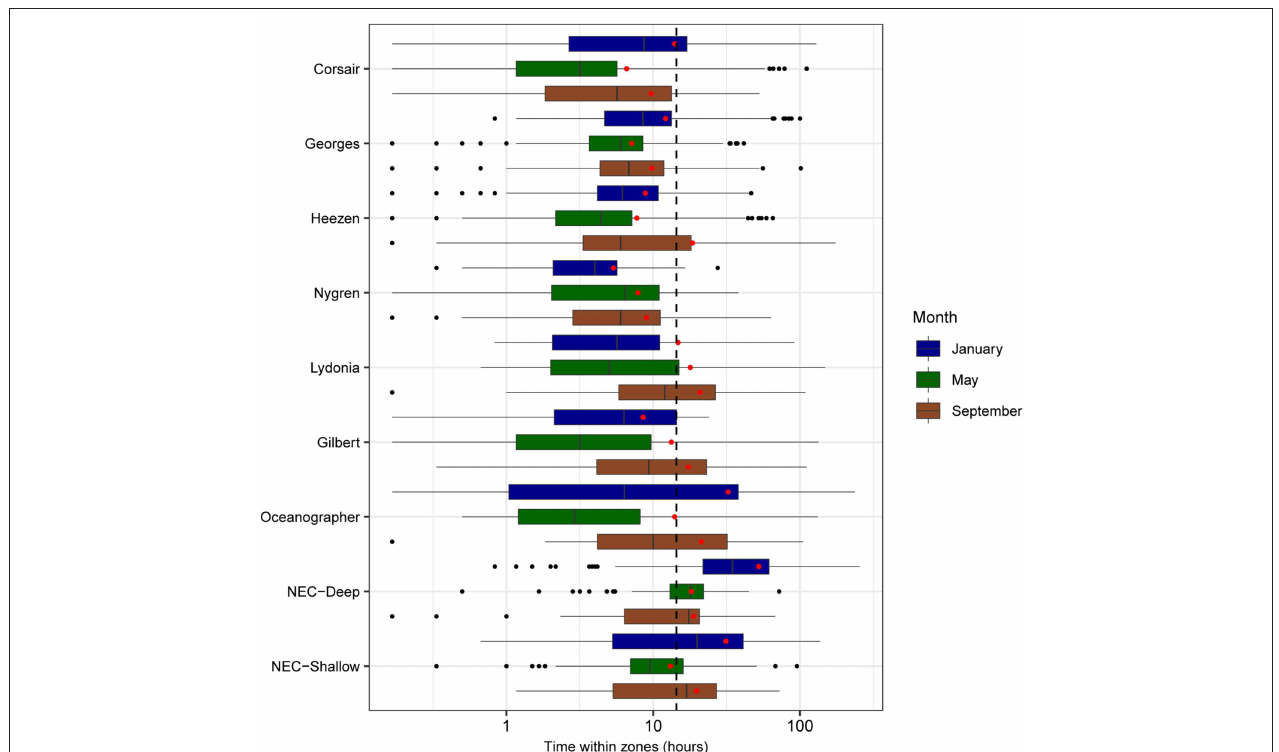
FIGURE 9 | Boxplots of residence time (h) for all tracks overlapping zones of interest segregated by month (sample sizes for the zone-month combinations are given in Table 4). Mean residence times for each month-zone combination are shown (red diamonds), as well as overall average (black dashed